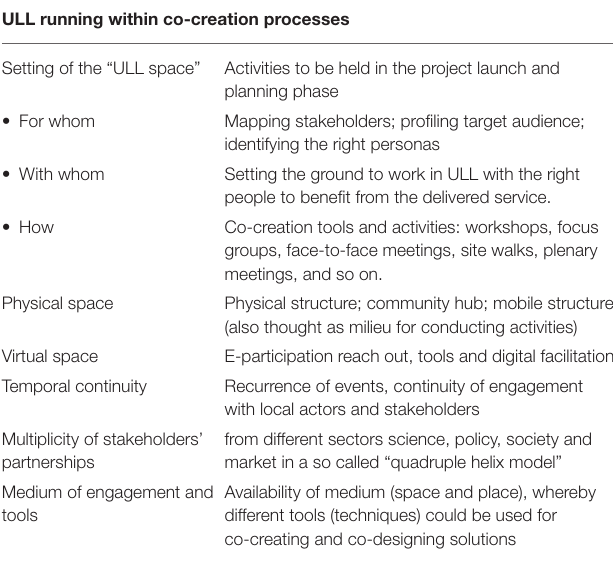
TABLE 1 | Running ULL dynamics within co-creation